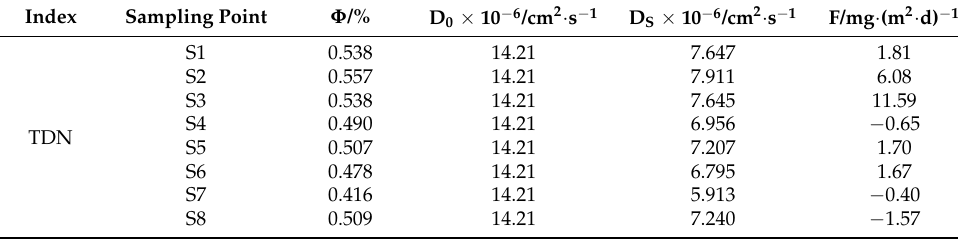
Table 6. Porosity, diffusion coefficient, and diffusion flux of TDN at the sediment–water interface of the Yitong River.